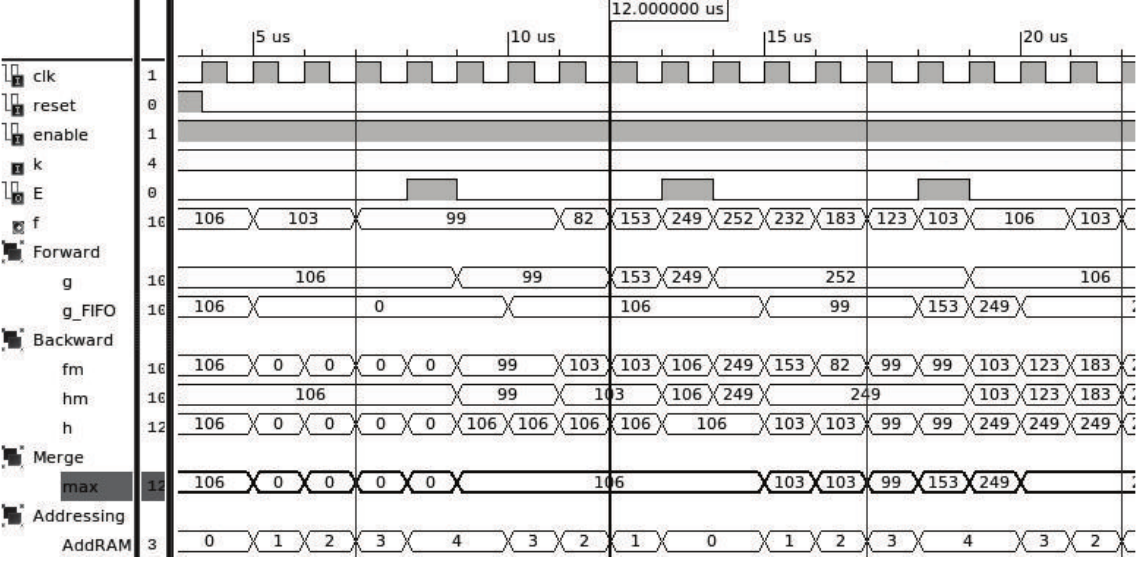
Figure 4: Timing diagram snapshot of the architecture functionality for running max filtering over the input pixel stream, 𝑓 , using a kernel of size 𝑘 = 5 . The first output result is produced at 12 microseconds as indicated by the vertical line; then, results are produced on each clock cycle. The signal 𝐴𝑑𝑑𝑅𝐴𝑀 shows the addresses generated through time used for accessing the synchronous single-port